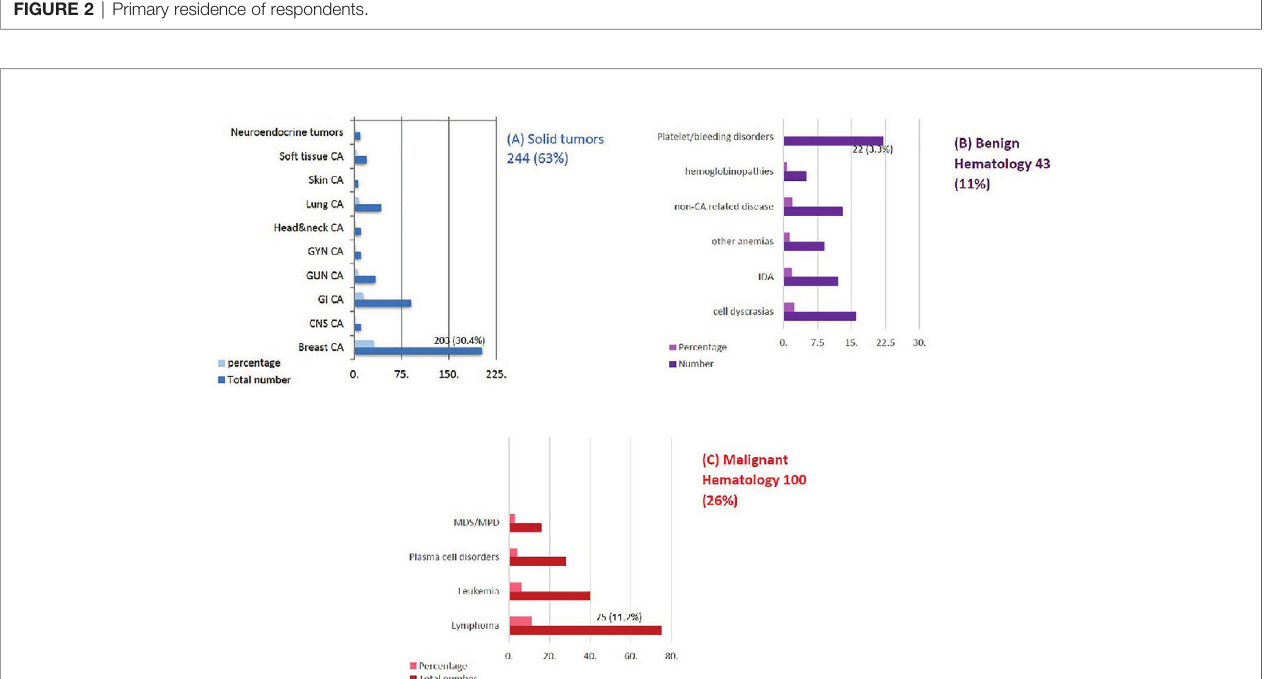
FIGURE 3 | Classi fi cation of Oncology Diagnoses of respondents at